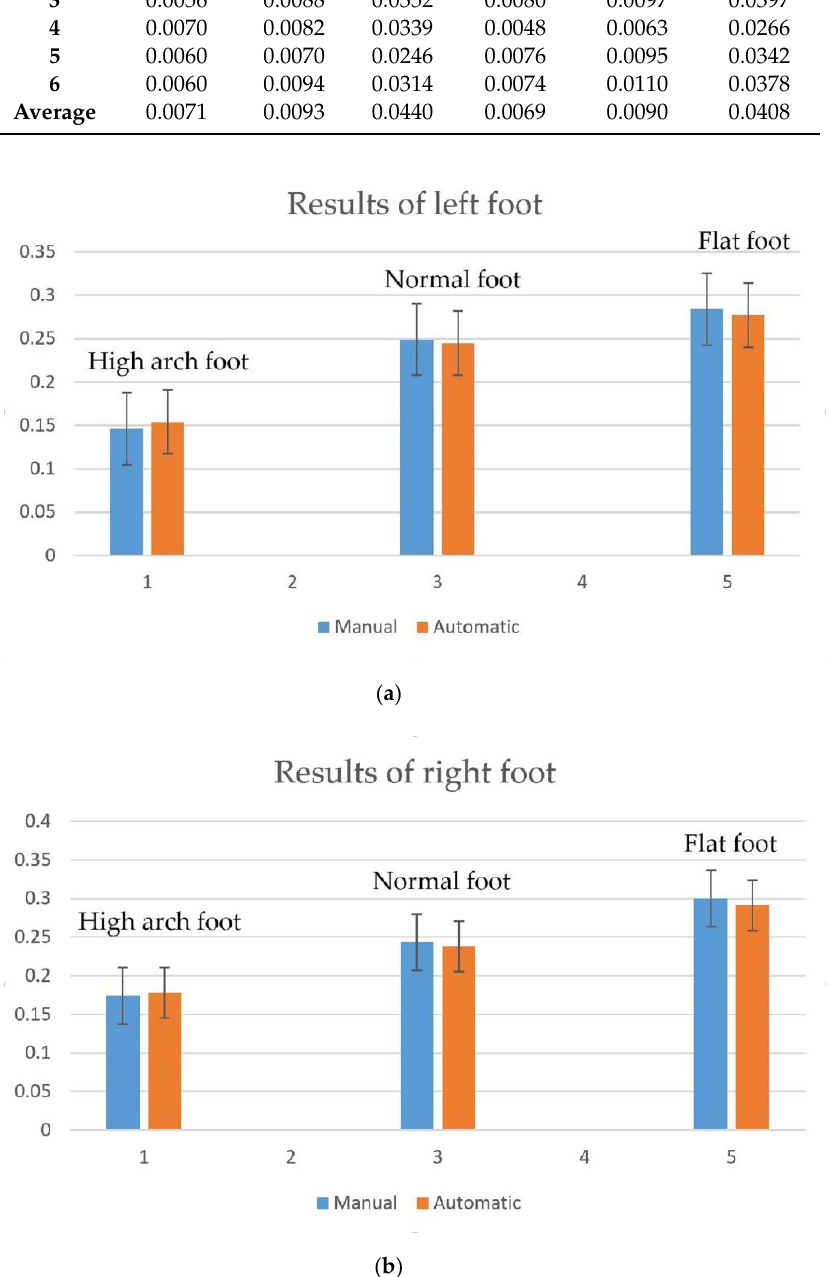
Figure 13. Comparison curve for the two measurement methods. ( a ) Comparison of left foot results. ( b ) Comparison of right foot results.